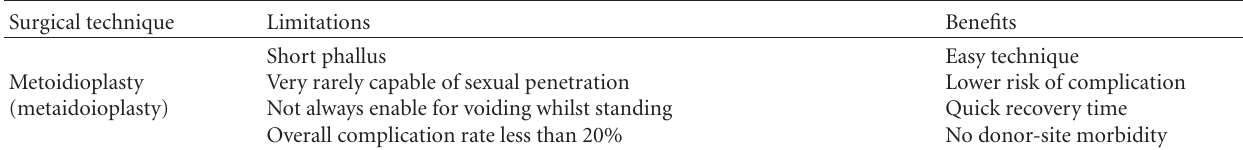
Table 3: Techniques for female-to-male sex reassignment surgery [18,